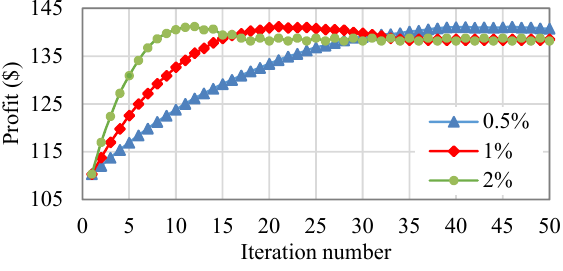
Figure 5. Profit maximization through the iterative Newton ‐ Raphson linear programming (NRLP) dispatch procedure without a demand response (DR) program.